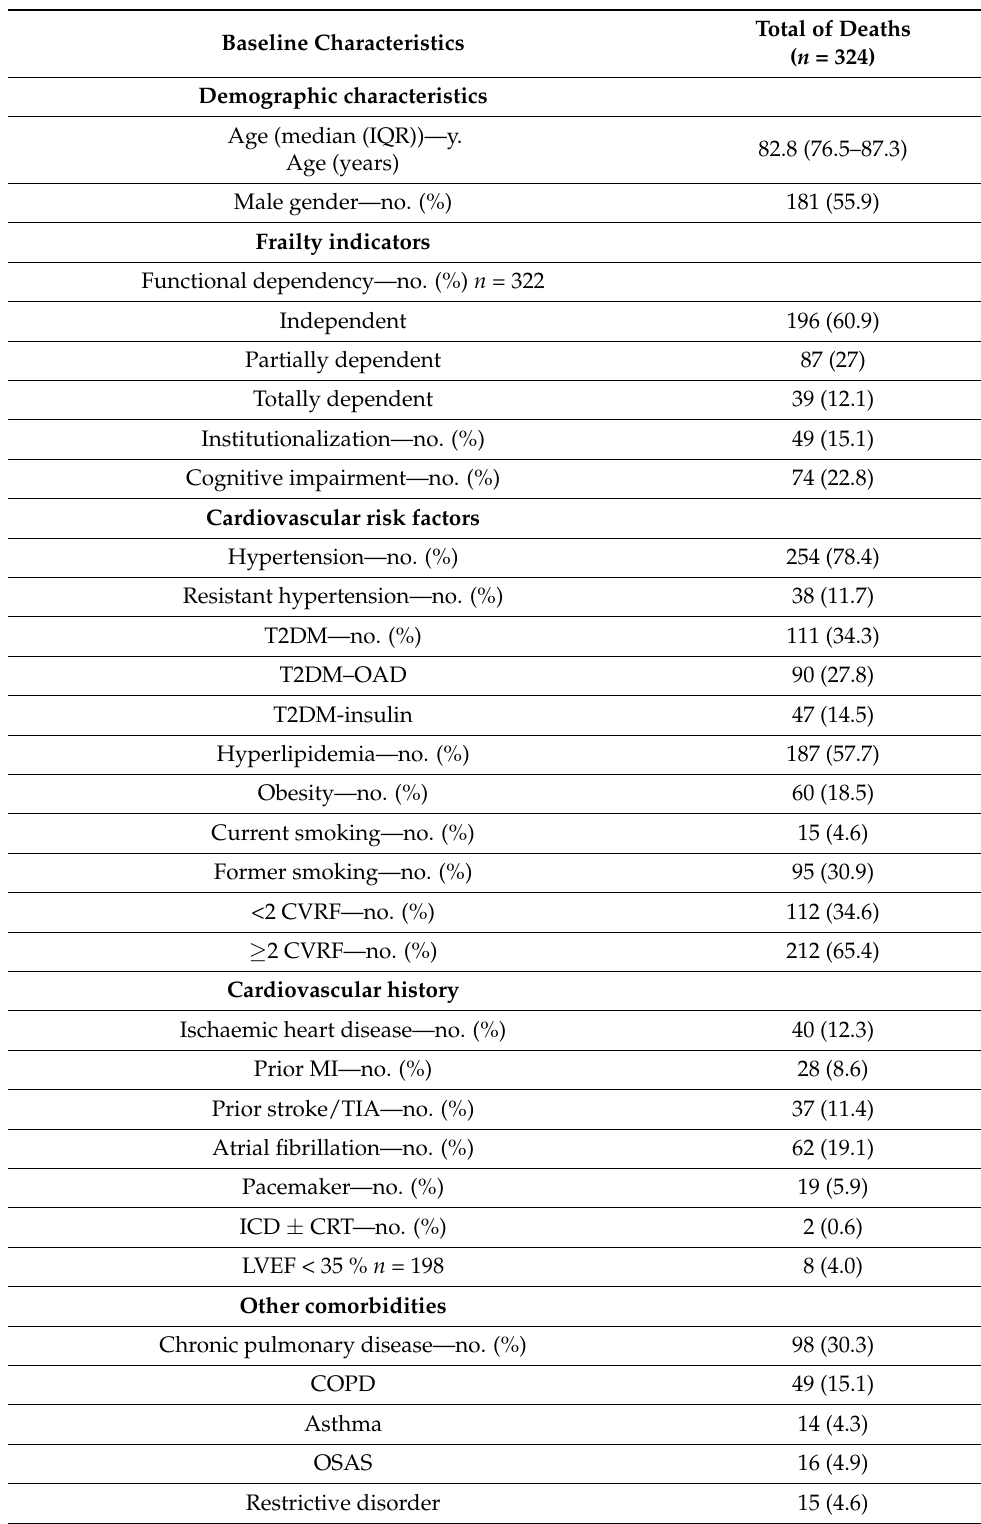
Table 1. Baseline characteristics of study